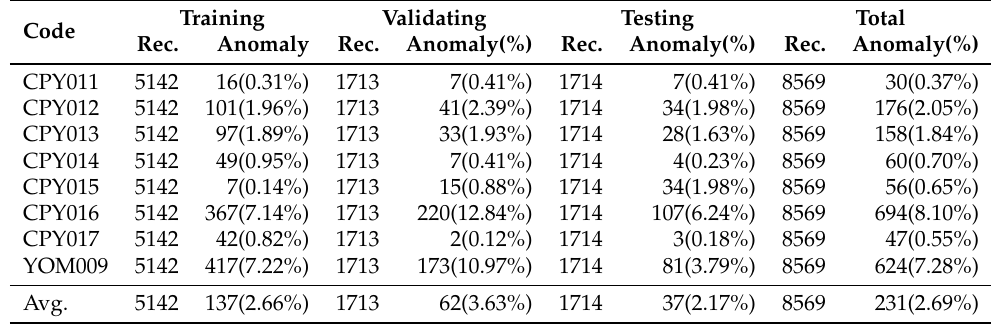
Table 1. Demographic summary of the water level data of 8 stations used in this research.